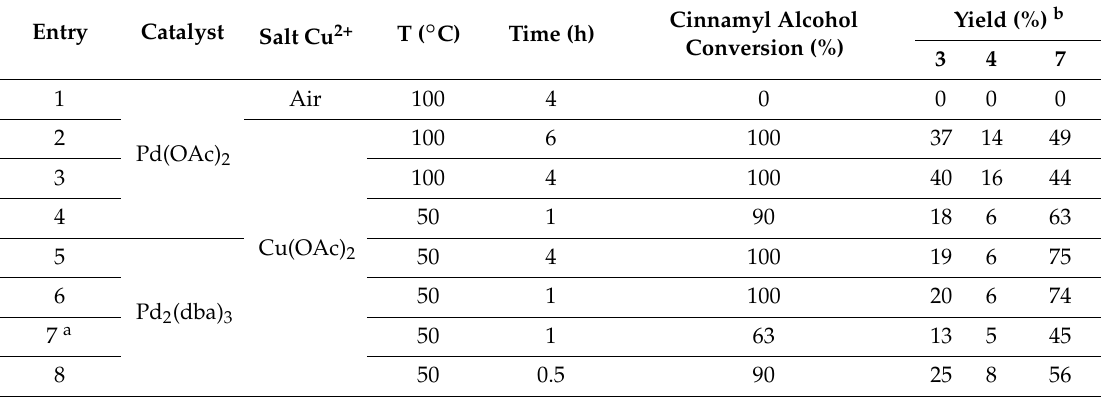
Table 6. Results of the Heck-type arylation of cinnamyl alcohol with phenylboronic acid.